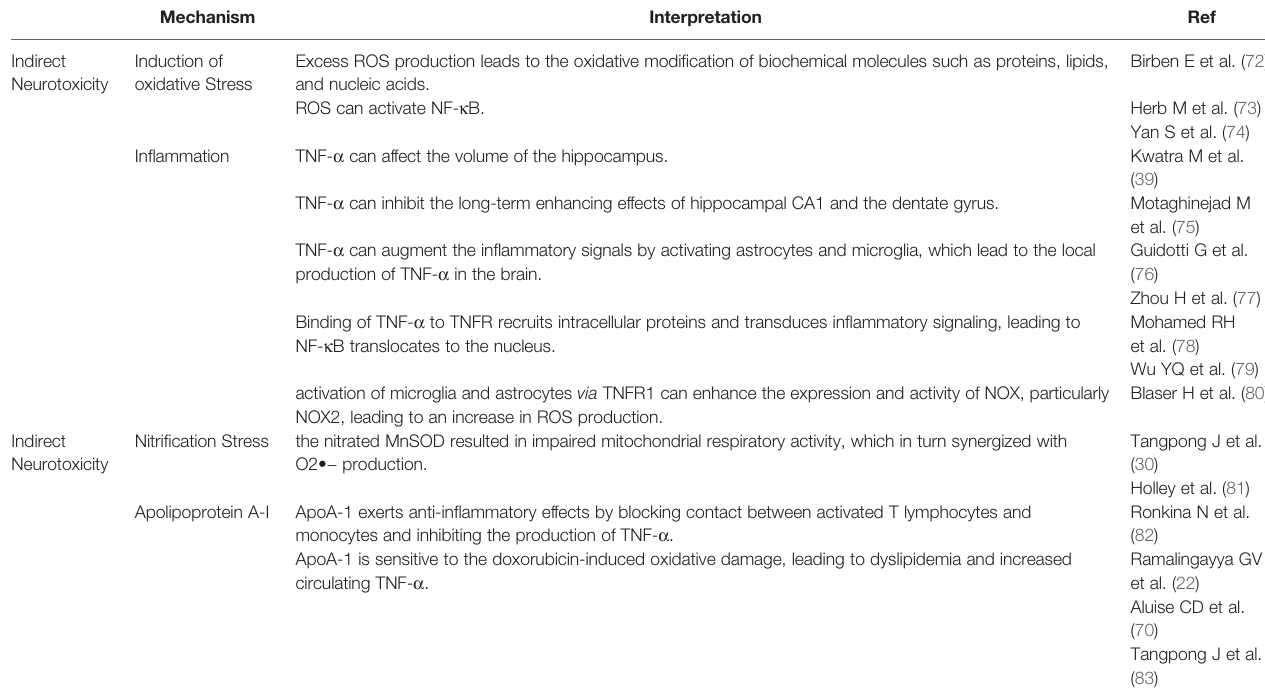
TABLE 2 | The indirect neurotoxicity of doxorubicin on